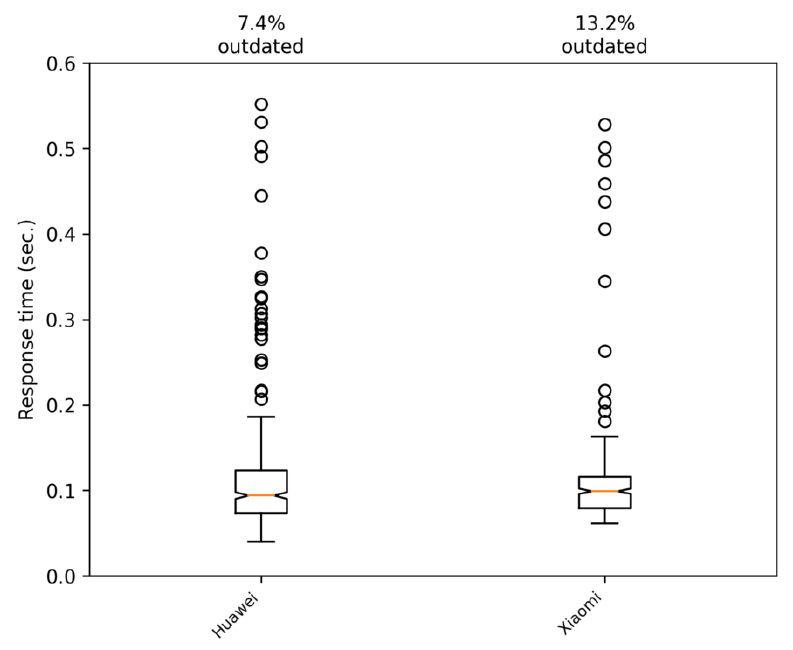
Figure 15. Comparing the two smartphones used in the tests. The data shown correspond to a car